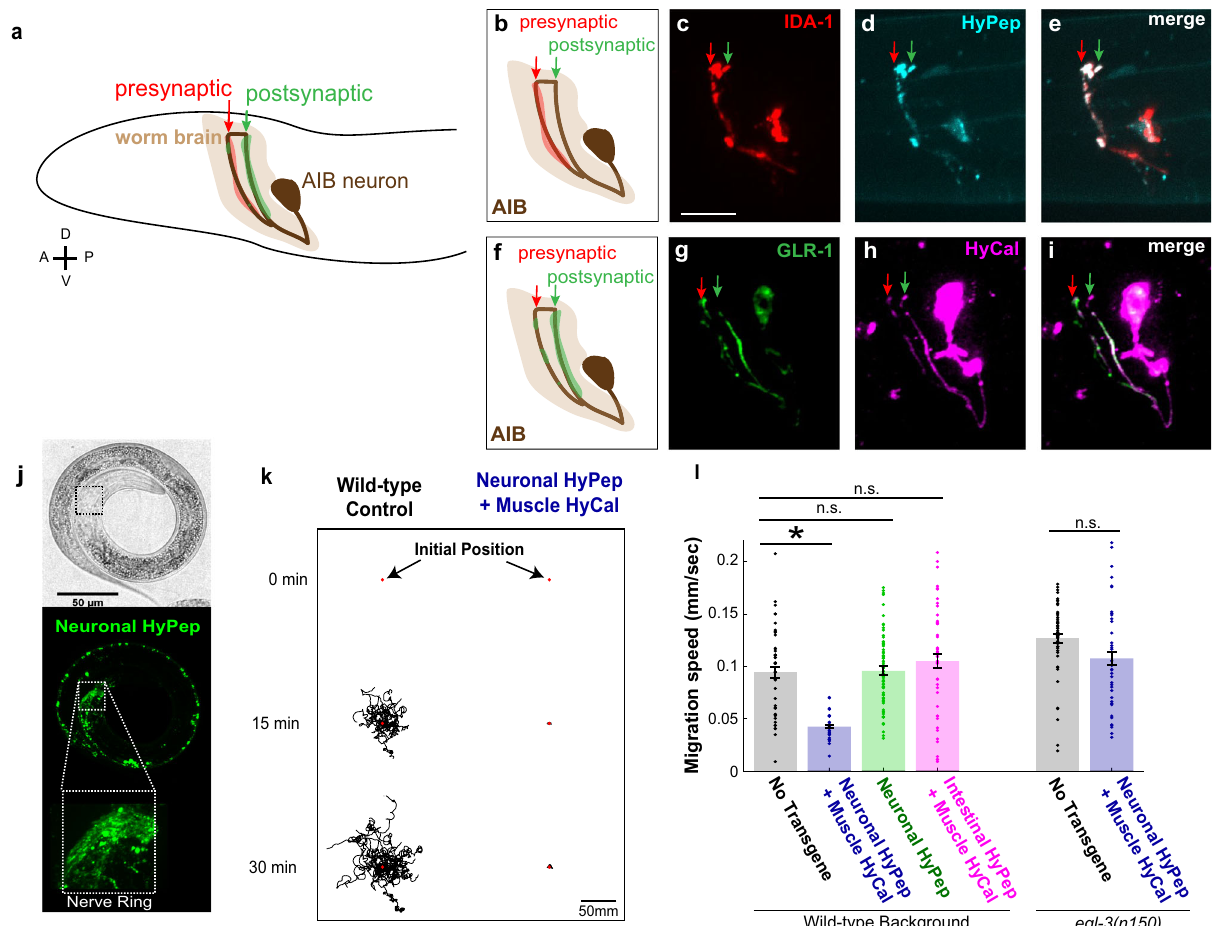
Fig. 3 HySyn components localize in vivo to appropriate synaptic compartments, and modify animal behavior. a Schematic of the worm head (black outline) illustrating the polarized distribution of synaptic specializations in the neuron AIB (brown) as determined by previous cell biological and electron microscopy studies 25,26 . Presynaptic sites are restricted to the region of the neurite most distal to the soma (indicated in red, “ presynaptic ” ). Postsynaptic specializations are enriched in the posterior soma-proximal region of the neurite (indicated in green, “ postsynaptic ” ). b – e Schematic illustrating enrichment of presynaptic specializations in the neuron AIB ( b red shading) and representative confocal images of the presynaptic dense-core vesicle marker IDA-1/phogrin:: mCherry 46 , ( c red), and the presynaptic component of HySyn, HyPep-eGFP ( d cyan). Overlay ( e “ merge ” ) showing colocalization of these markers in the presynaptic compartment of the neurite (red arrow marks the position of the distal neurite enriched for presynaptic specializations, as shown in schematic in b ). The scale bar in c is 10 µ m. f – i Schematic illustrating enrichment of postsynaptic specializations in the neuron AIB ( f green shading) and representative confocal images of the postsynaptic receptor GLR-1::GFP 26 ( g green), and the postsynaptic component of HySyn, HyCal-mCherry ( h magenta). Overlay ( i merge) showing that within the AIB neurite these two elements colocalize predominantly to the soma-proximal postsynaptic region (green arrow marks the position of the proximal neurite enriched for postsynaptic specializations, as shown in the schematic in f ). Bright- fi eld ( j top) and fl uorescence ( j bottom) micrographs show the pattern of expression for HyPep-GFP under the control of a pan-neuronal promoter in the nematode C. elegans . The fl uorescence pattern (green, bottom panel) shows a dense collection of puncta in the nerve ring (inset), a synaptic-rich neuropil. k Illustration of trajectories for 24 worms over a 30min observation period. Each line represents a single worm track from a commonly aligned initial position (red dot) after either a 0min (top), 15min (middle), or 30 min (bottom) monitoring period. Compared to the dispersion of wild-type control (left), transgenic animals expressing the synthetic HySyn connection between neurons and muscles (right, “ Neuronal HyPep + Muscle HyCal ” ) showed substantially reduced migration over time. l During infrequent bouts of detectable migration in this 30min interval, those animals expressing the full HySyn system ( “ Neuronal HyPep + Muscle HyCal ” , blue) move at a slower speed than control animals without HySyn ( “ No Transgene ” , black) ( p = 0.000001 for wild-type ( n = 43) vs “ Neuronal HyPep + Muscle HyCal ” ( n = 24)). Neither the neuropeptide itself ( “ Neuronal HyPep ” , green) nor the receptor in the presence of intestine-produced neuropeptide ( “ Intestinal HyPep + Muscle HyCal ” , magenta) altered migration speeds ( p = 1.0 for wild-type ( n = 43) vs “ Neuronal HyPep ” ( n = 68), p = 1.0 for wild-type ( n = 43) vs “ Intestinal HyPep + Muscle HyCal ” ( n = 45)). Migration in animals carrying a mutation of egl-3(n150 ), a gene required for neuropeptide maturation. The egl-3(n150 ) mutation suppressed the function of the reconstituted HyPep-HyCal connection (right-most bar, blue) based on comparison of egl-3(n150) mutants with “ Neuronal HyPep + Muscle HyCal ” ( n = 37) to wild-type ( n = 43, p = 1.0) or egl-3(n150) mutant animals without transgene expression ( n = 52, p = 0.1243). Error bars indicate 95% con fi dence intervals and * indicates p <0.05 using two-tailed Mann – Whitney – Wilcoxon test with Bonferroni correction for multiple planned comparisons. Source data are provided as a Source Data fi